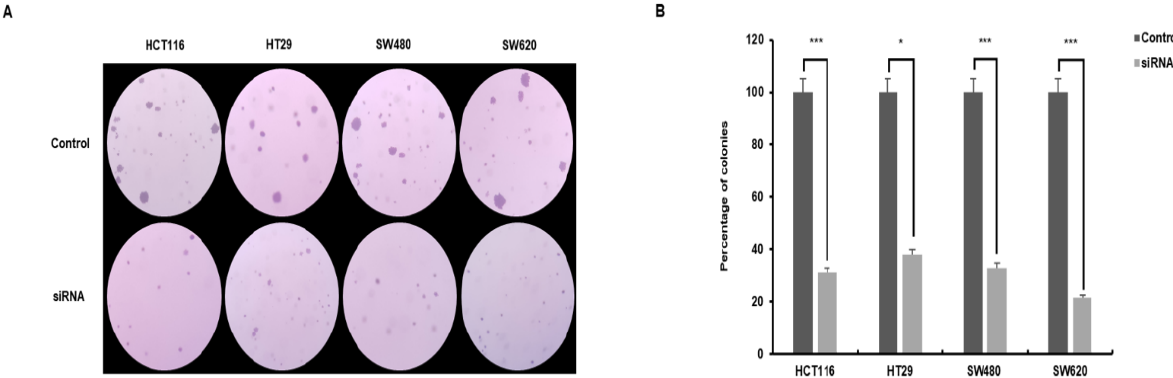
Figure 4. The result of thee semisolid agar colony-forming assay. Anchorage-independent growth in soft agar was examined with control cells and cells that displayed downregulation of SMOX expression. The numbers of colonies were measured after 14 days. Colony formation in the siRNA- treated group was reduced compared to that in the control group (HCT116, 31%; HT29, 38%; SW480, 33%; and SW620, 21%). Colonies were visualized in violet color. ( A ) Comparison of the growth of colonies with control cells and siRNA-treated cells (Original magnification × 40). ( B ) The graph indicates the number of colonies and the percentage difference between the control cells and siRNA- treated cells (* p < 0.05, *** p < 0.001).